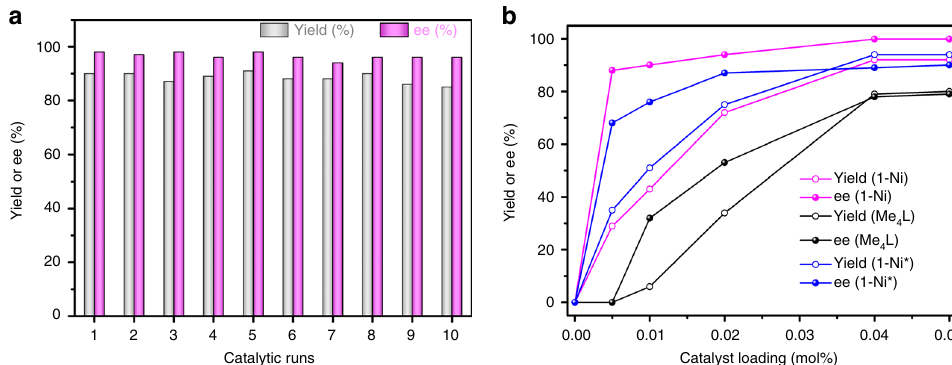
Fig. 4 Recycle and con fi nement effect. a Recycling tests of the HOF 1 -Ni catalyst in the [3 + 2] coupling reaction of 3-methyl indole with quinone monoamine. b Plots of the [3 + 2] coupling reaction of 3-methyl indole with quinone monoimine at different catalyst loadings (catalyst loadings of Me 4 L and 1 -Ni* are 6 and 0.75 times of HOF 1 -Ni,